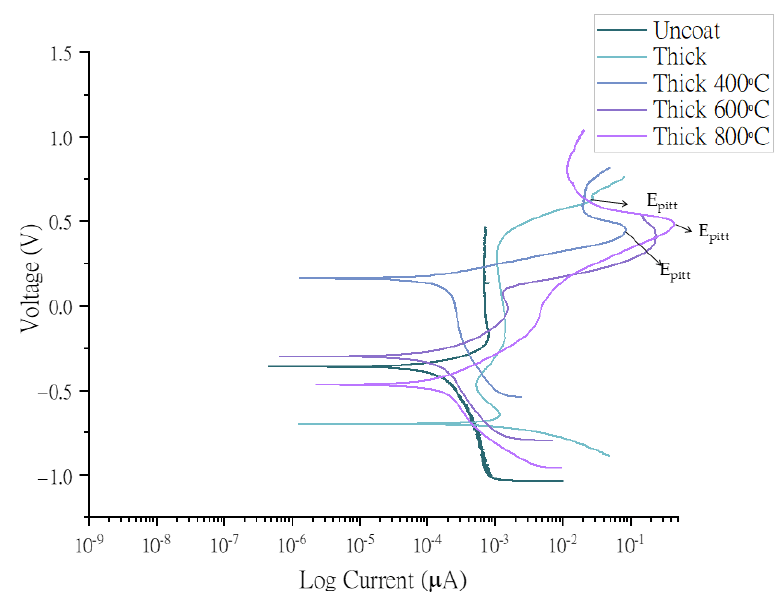
Figure 6. Polarization curves of Co30Cr20Ni20Mo20Ti10 alloy versus Ag/AgCl electrode in Hank’s solution. Working electrode was deposited at 5 × 10 5 ion density (thin coat) without heat treatment and with heat treatment at 400 °C, 600 °C, and 800 °C.